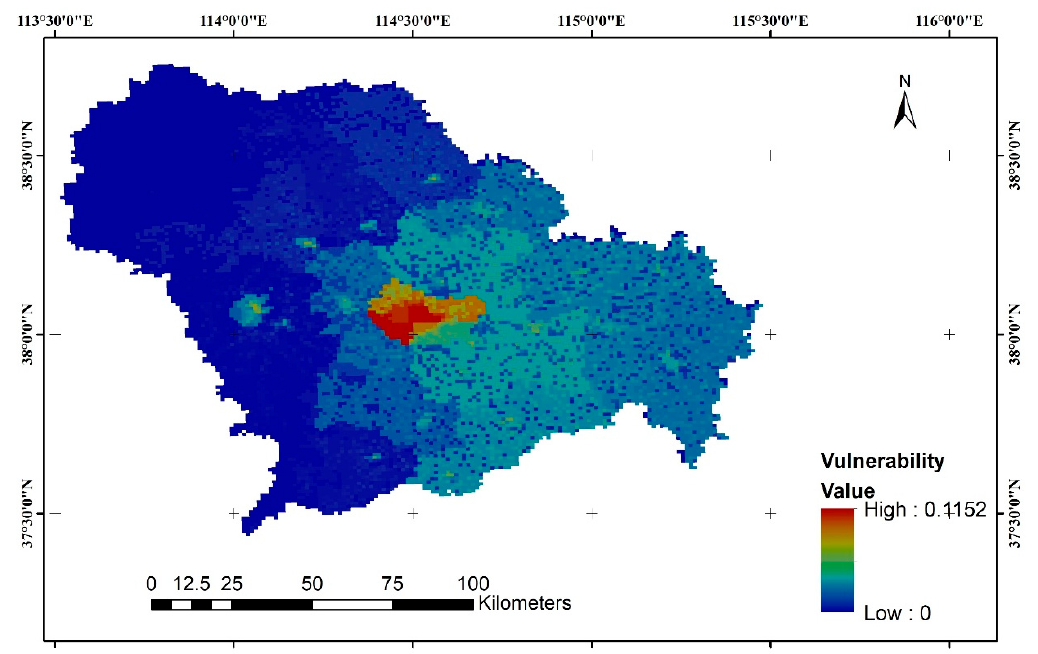
Figure 5. Flood disaster potential factor map of Shijiazhuang.